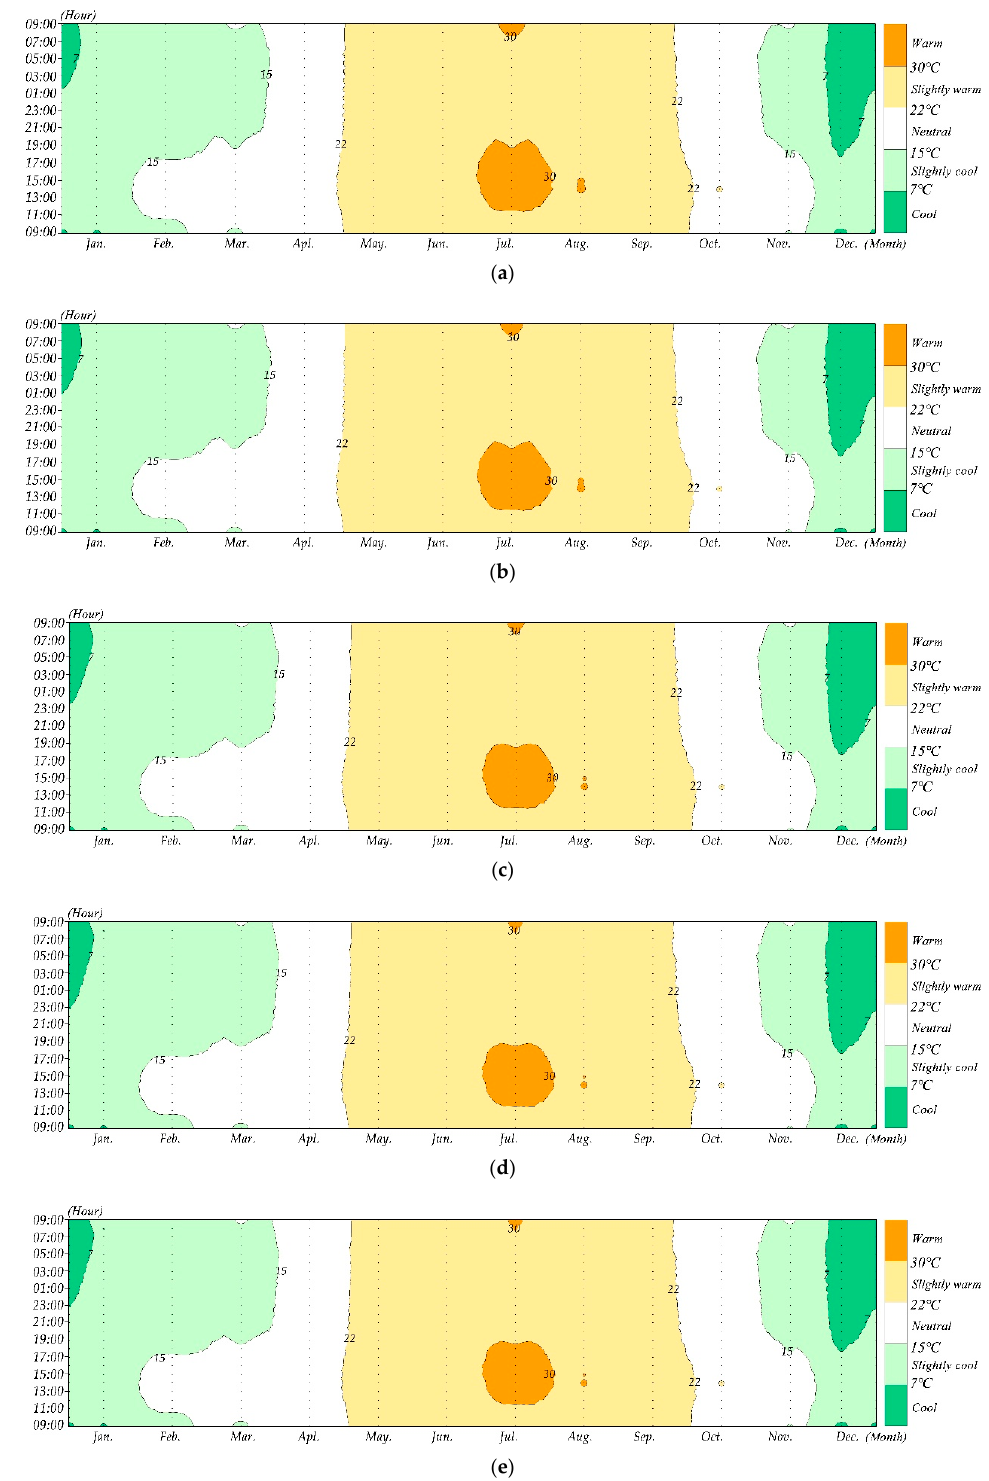
Figure 5. Annual thermal sensations modified by the five roof greening rates. ( a ) Indoor thermal sensation of 0% green roof rate scenario; ( b ) Indoor thermal sensation of 25% green roof rate scenario; ( c ) Indoor thermal sensation of 50% green roof rate scenario; ( d ) Indoor thermal sensation of 75% green roof rate scenario; ( e ) Indoor thermal sensation of 100% green roof rate